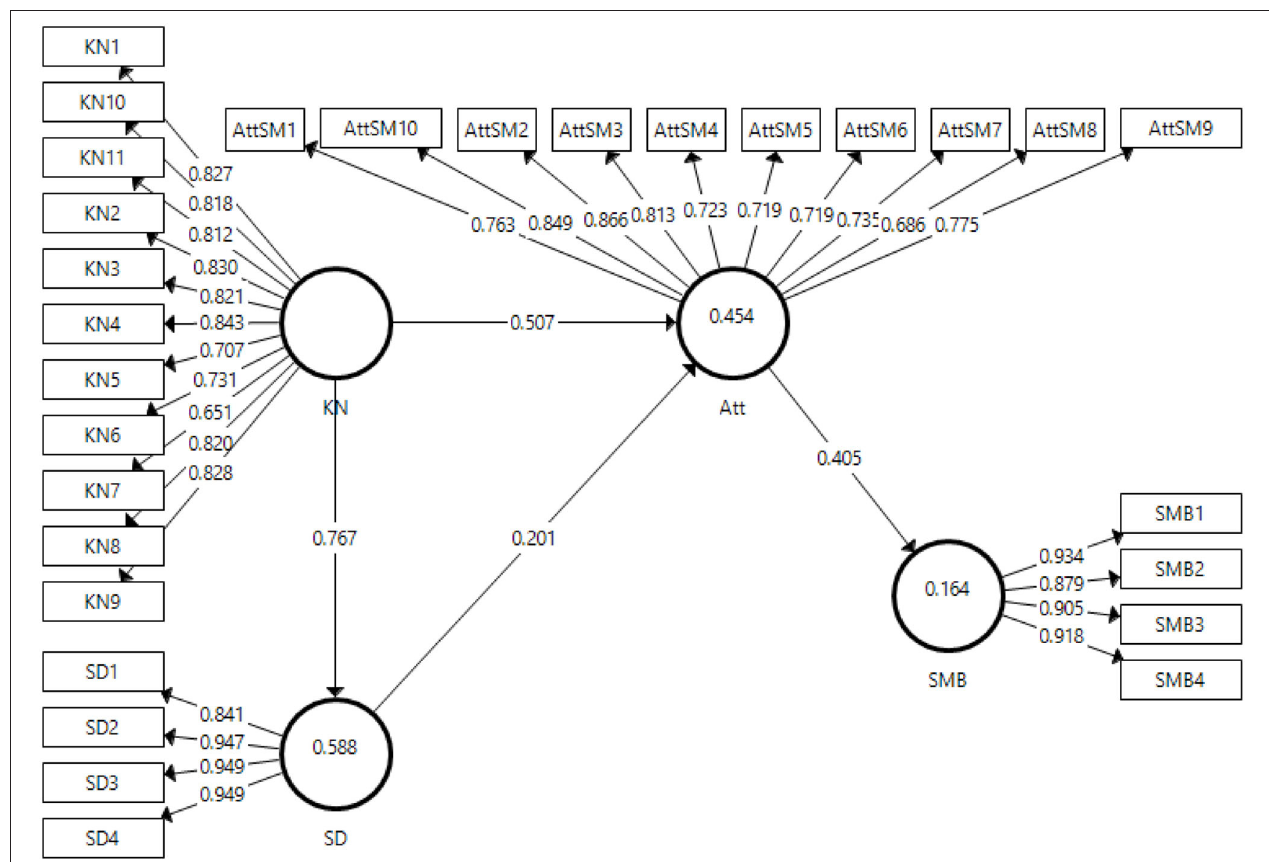
FIGURE 2 | Measurement model